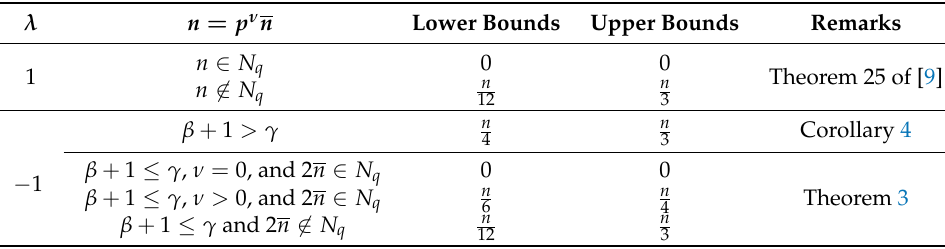
Table 1. The lower and upper bounds for E ( n ,1, q ) and E ( n , − 1, q ) . λ n = p ν n Lower Bounds Upper